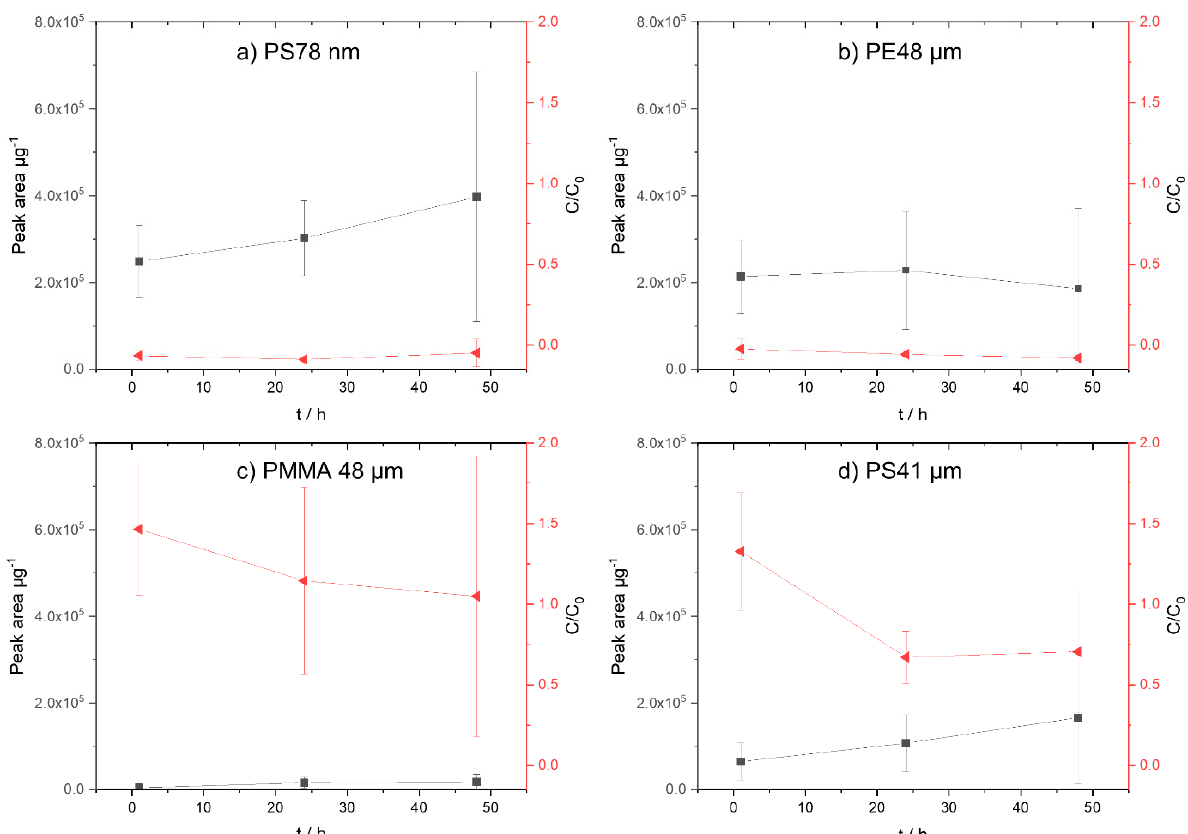
Figure 2. Concentration of phenanthrene on micro- and nanoplastic particles. On the left y − axis (black, square), the sorption on the particles (peak area µ g − 1 ) is shown; on the right y − axis (red, triangle), the normalized concentration in the aqueous phase (C/C 0 ) is presented. ( a ) PS 78 nm, ( b ) PE 48 µm, ( c ) PMMA 48 µm, and ( d ) PS41 µm.